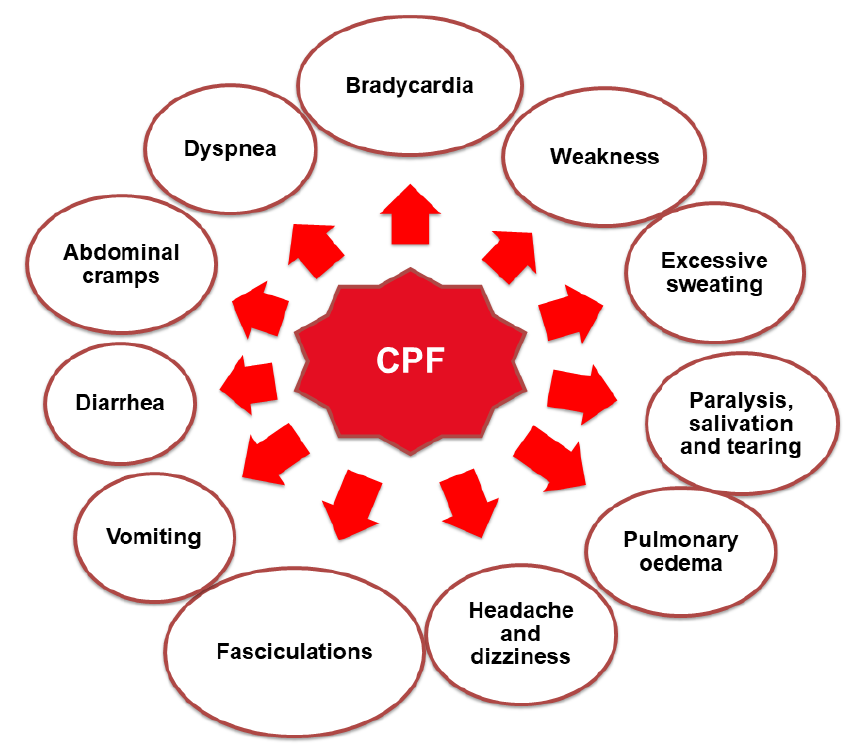
Figure 3. Undesirable health effects of exposure to CPF.